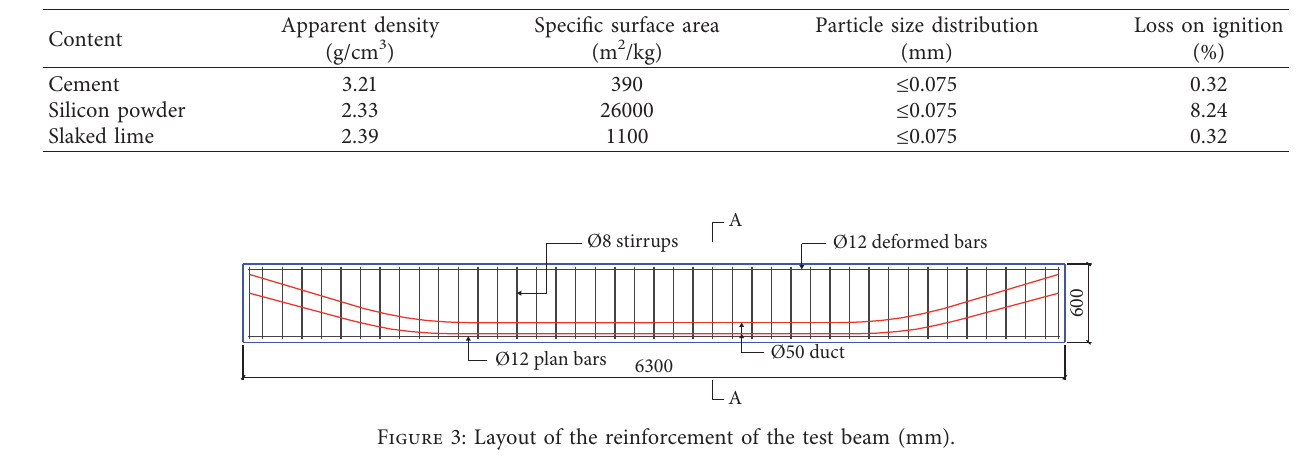
Figure 2: Admixtures for test. (a) Cement. (b) Silicon powder. (c) Slaked lime. Table 4: Basic properties of admixtures.